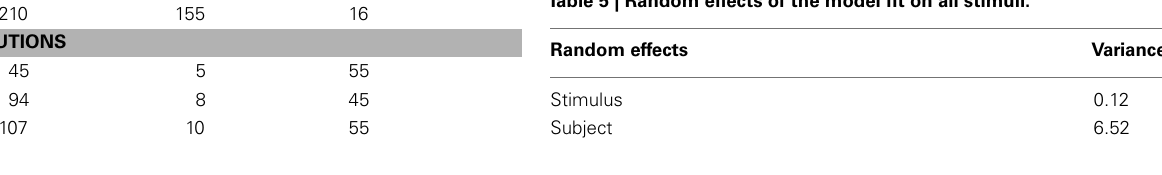
Table 5 | Random effects of the model fit on all